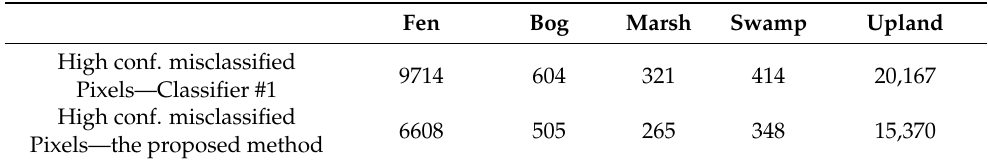
Table 7. Number of the misclassified pixels with high confidence and their land cover assignments for the traditional and proposed